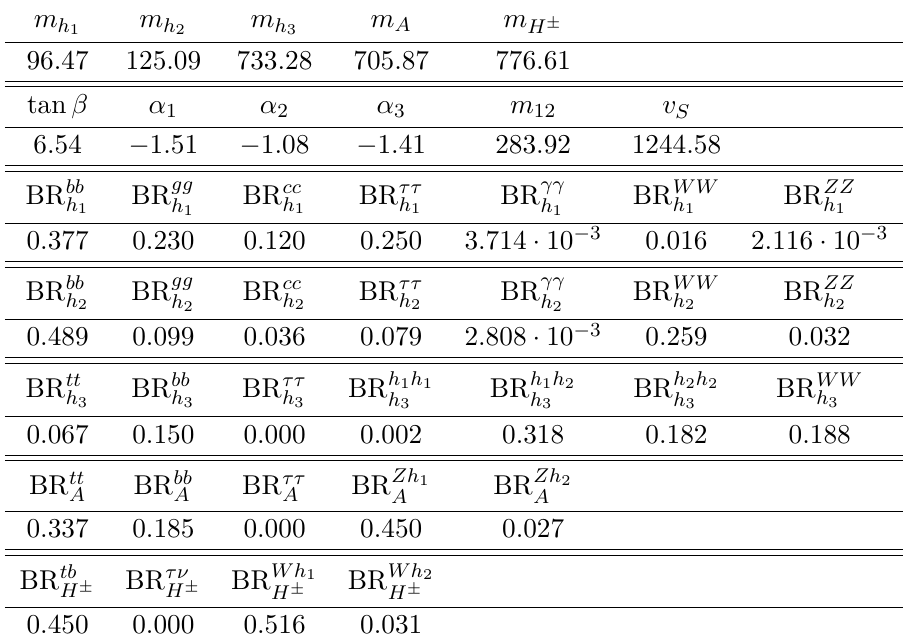
is found under the γγ + ττ + bb = 91 . 47 ). Also shown are the branching 125